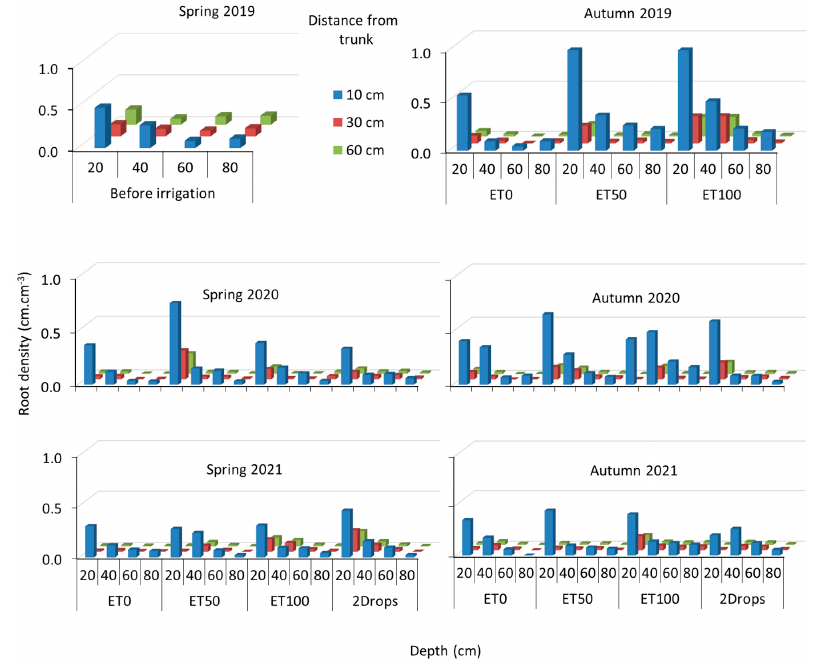
Figure 7. Distribution of new vital roots (RDv) in soil profile to a depth of 80 cm at distances of 10 cm, 30 cm, and 60 cm from the trunk. ET0, ET50, ET100, and 2Drops refer to irrigation water rate variants (see Figure 5).